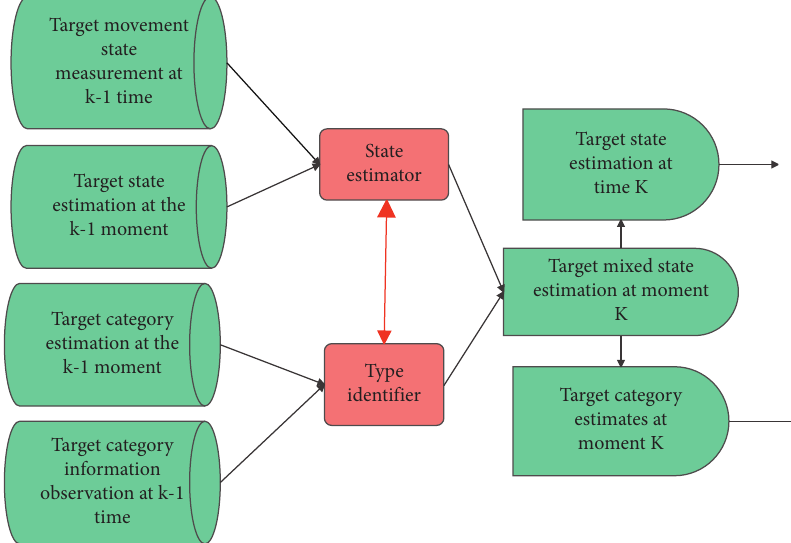
Figure 5: Schematic diagram of JTC algorithm framework.